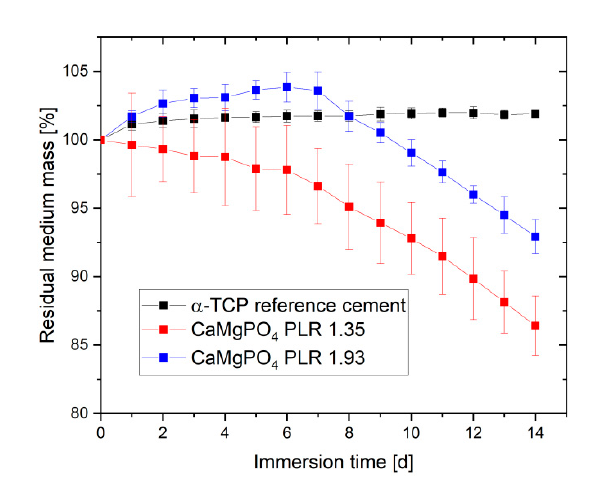
Figure 6. Dissolution profiles of 24 h stored cement pastes, which were hardened in 3.5 M (NH 4 ) 2 HPO 4 solution for 24 h. Samples were immersed in 10 mL PBS buffer at 37 ◦ C over a course of 14 d with a daily change in the immersion liquid ( n = 5).